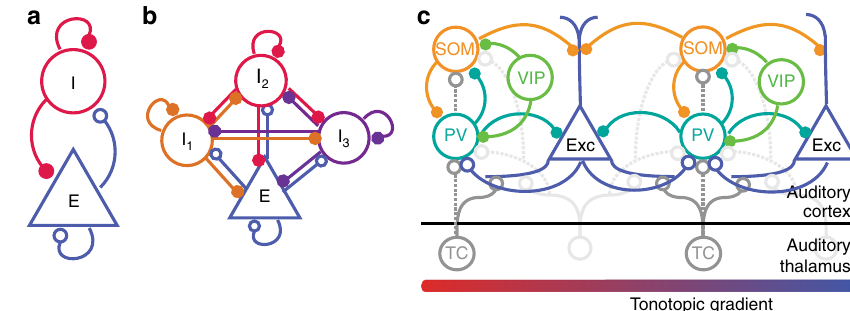
Fig. 1 Simpli fi ed views of cortical circuits. ( a ) Diagram of excitatory – inhibitory circuit with recurrent connections. Theoretical and experimental studies demonstrate that inhibition stabilizes between excitatory and inhibitory neurons in the auditory cortex. ( b ) Inhibitory – excitatory network can be extended to include several interneuron subtypes. ( c ) Schematic diagram of connectivity between select neurons in the auditory cortex (note that layer-speci fi c information is omitted here): Exc: Excitatory neurons; PV: parvalbumin-positive interneurons; SOM: somatostatin-positive interneurons; VIP: vasopressin- positive interneurons; TC: Thalamo-cortical projection neurons. All neuron types receive additional inputs from other brain areas, which were omitted from the diagram for simplicity. Open circles: excitatory synapses; closed circles: inhibitory synapses. Solid lines indicate dominant projections; dashed lines indicate occasional